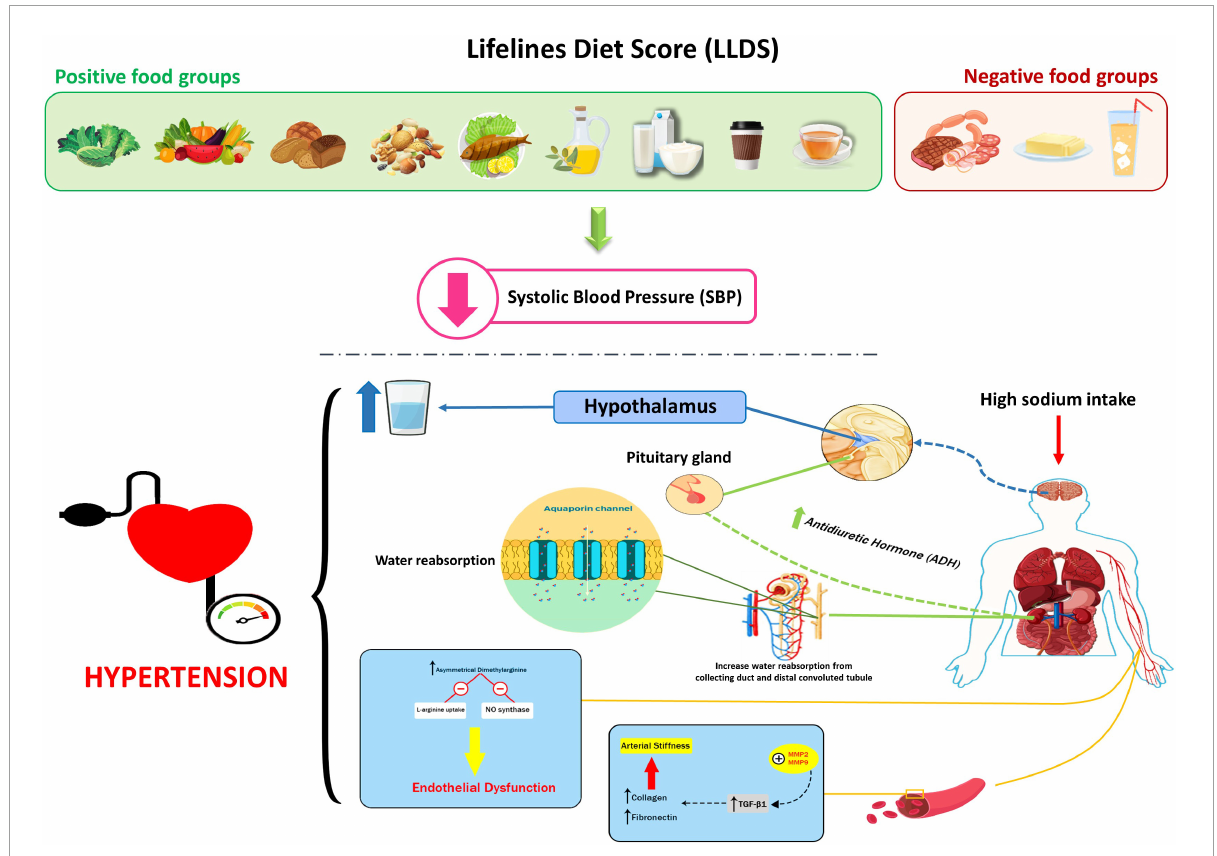
FIGURE2 High dietary sodium intake can induce high blood pressure through the renin angiotensin system, which leads the hypothalamus to stimulate thirst and increase water intake. Also, it stimulates anti-diuretic hormone (ADH) secretion from the pituitary gland (77), which increases the aquaporin channels in the collecting duct and distal convoluted tubule (78). A high sodium intake activates extracellular matrix metalloproteinases MMP2 and MMP9, stimulating TGFß-1, inducing thinning and breakage of elastin fibers, and decreasing the elastin and collagen ratio. Also, TGFß-1 inhibits collagenase production and develops a fibrogenic effect on the extracellular matrix in the arterial wall, altering its mechanical properties and causing arterial stiffness (48). Asymmetrical dimethylarginine (ADMA) is a major endogenous inhibitor of NO bioavailability through its capacity to inhibit NO synthase and also increase oxidative stress